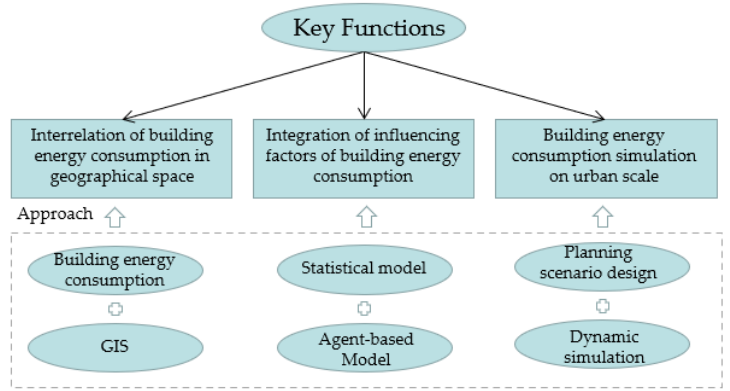
Figure 1. The general idea of the model design.